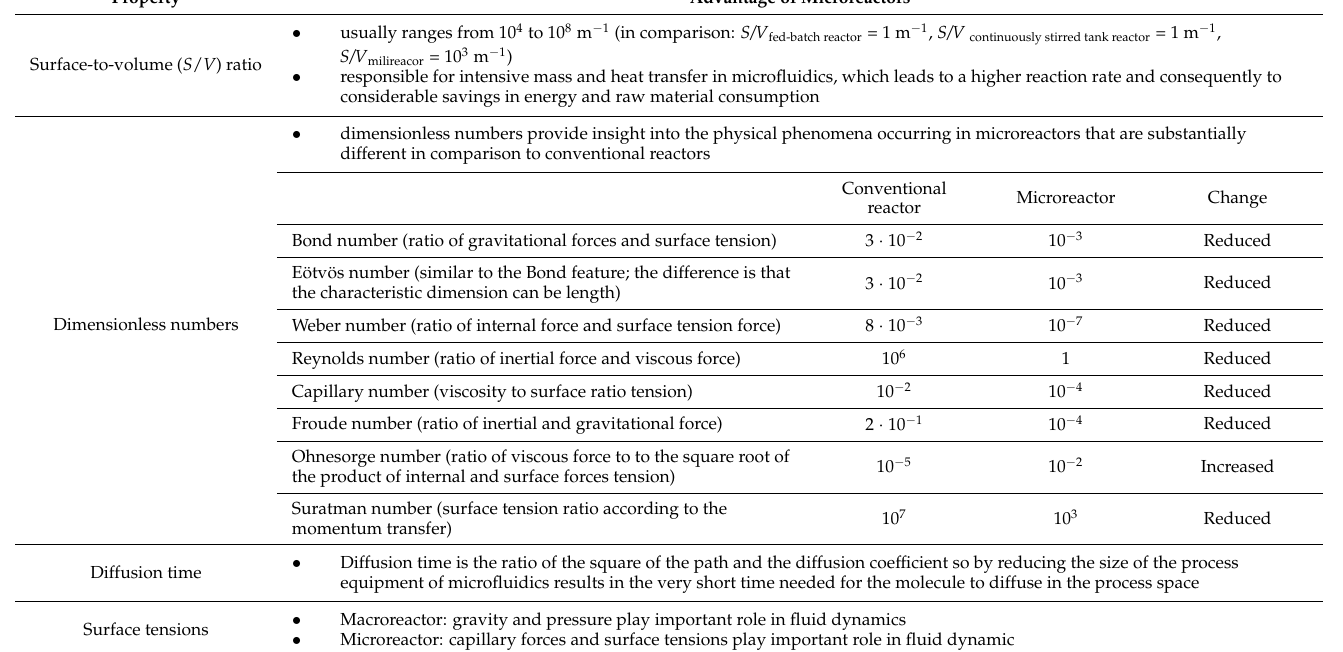
Table 4. Advantages of microreactors in comparison to conventional reactors. Advantage of